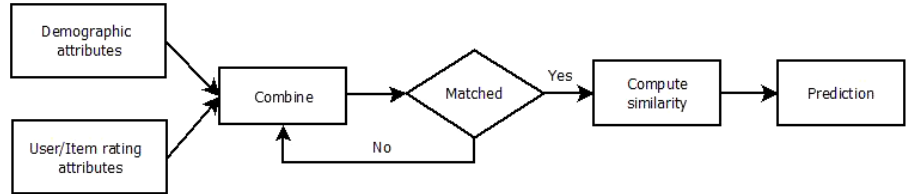
Fig. 1. The architecture of the proposed